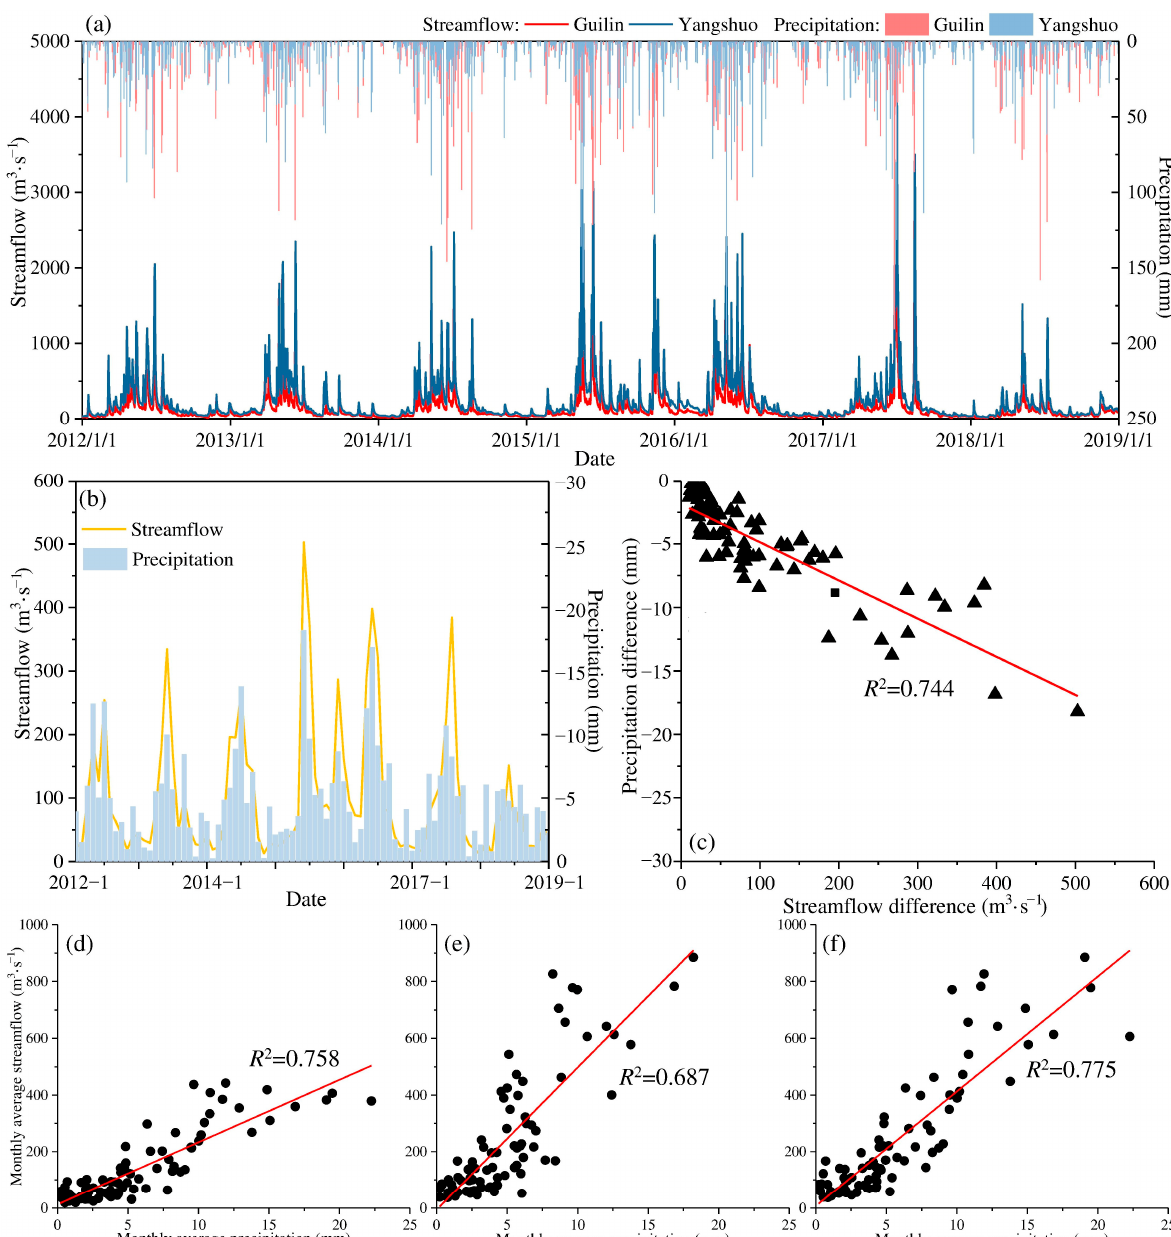
Figure 3. Characteristics of streamflow and precipitation changes in Guilin and Yangshuo stations, ( a ) Streamflow and precipitation, ( b ) Difference between Yangshuo and Guilin, ( c ) Correlation between difference of streamflow and precipitation, ( d ) Correlation between streamflow and precipitation at Guilin, ( e ) Correlation between streamflow and precipitation at Yangshuo, and ( f ) Correlation between streamflow at Yangshuo and precipitation at Guilin.